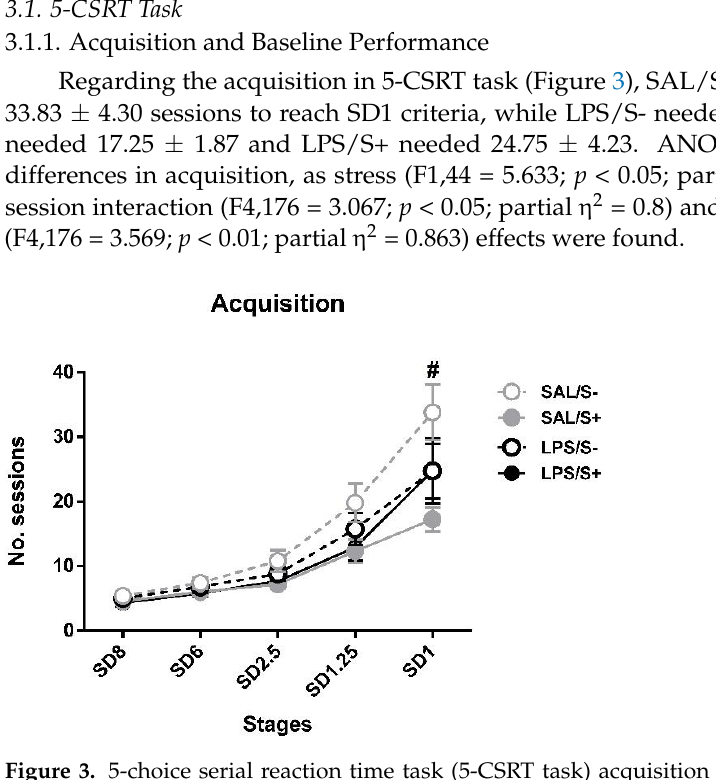
Figure 3. 5-choice serial reaction time task (5-CSRT task) acquisition in saline-control (SAL/S-), LPS-control (LPS/S-), saline-stress (SAL/S+), or LPS-stress (LPS/S+) groups ( n = 12). Mean number of sessions to criterion are represented at several stimulus durations (SD): 8, 6, 2.5, 1.25, and 1 s; at SD = 1, SAL/S+ (# symbol) group needed significantly fewer sessions than SAL/S- group to reach criterion. Data are represented as mean ± SEM.